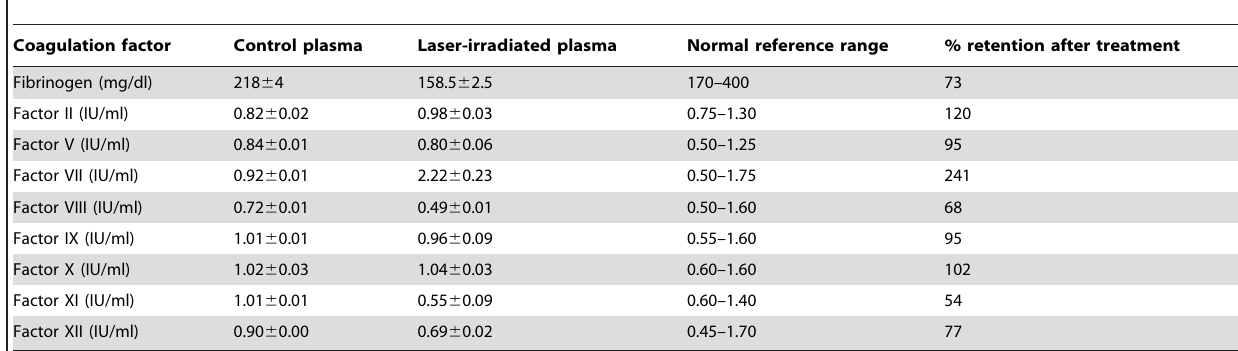
Table 1. Retention of coagulation factor activity for USP laser-treated plasma.